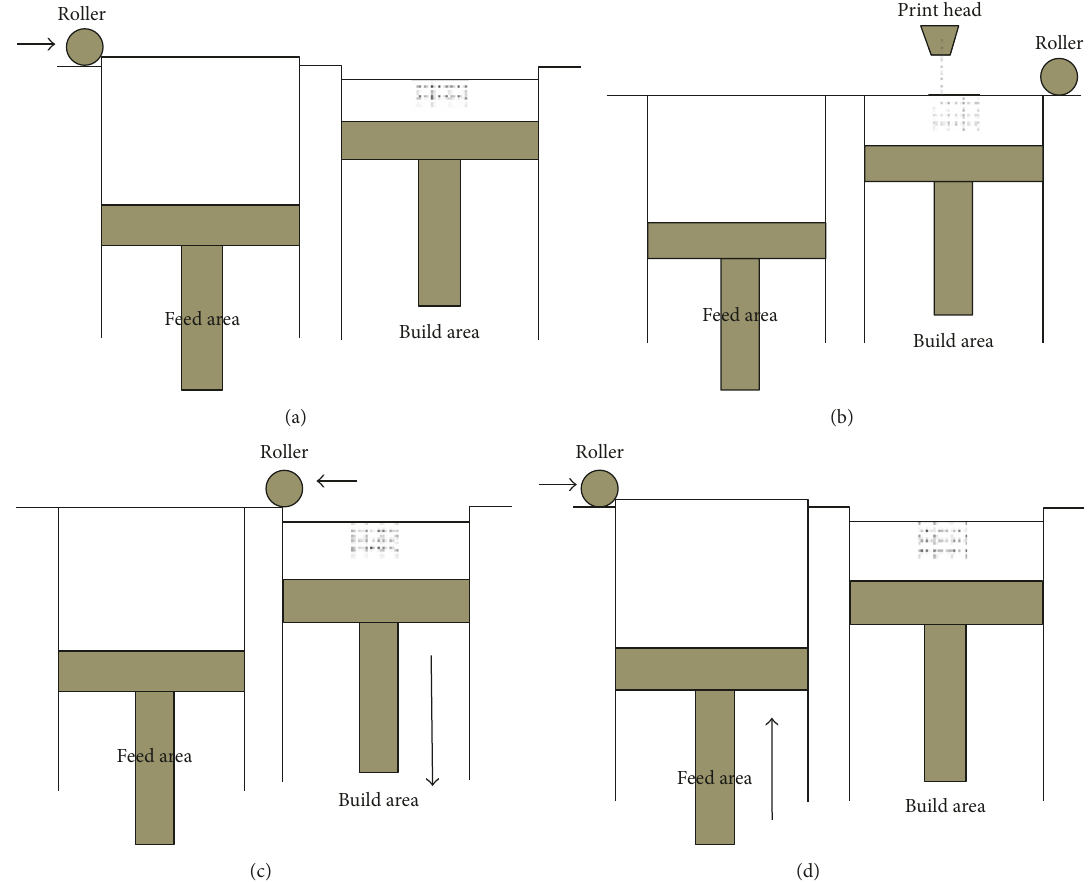
Figure 2: 3DP process scheme. (a) The roller spreads a thin layer of powder from the feed area to the build area. (b) The print head injects binder droplets on the powder bed. (c) After printing a layer, the roller returns to the feed area. (d) Powder in the feed area is raised, while that in the build area is lowered. The roller then spreads another layer of powder